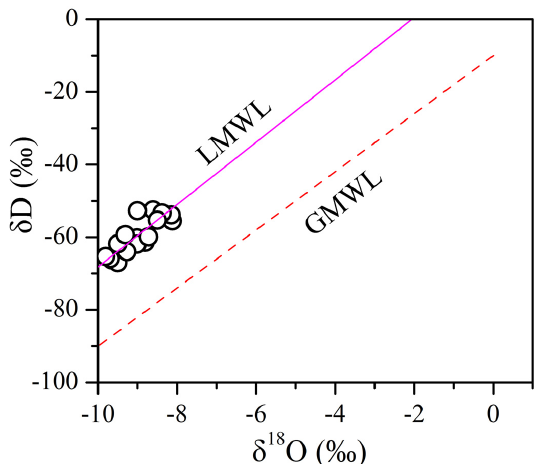
Figure 4. Oxygen and hydrogen isotope of groundwater samples associated with Global Meteoric Water Line (GMWL) and Local Meteoric Water (LMW) in the study area.